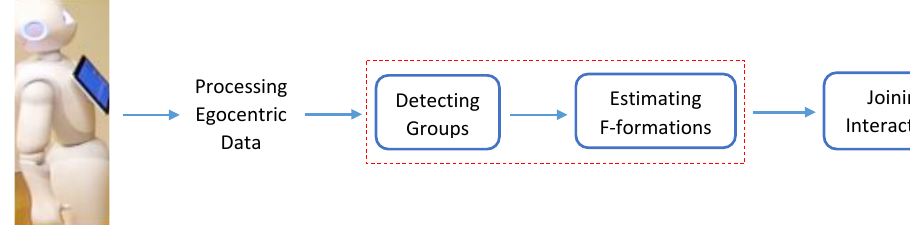
Figure 1. In our framework, the robot joining an ongoing social group interaction involves four steps. First, robot perceives the scene using on-board sensors and extracts hand-engineered features. Second, the features are used to detect groups in the scene. Furthermore, the robot recognizes the patterns of groups by estimating the F-formations, and, finally, the robot finds the optimal spot and joins the ongoing social group interactions. The steps in the red rectangle—detecting groups and estimating F-formations—are addressed in this